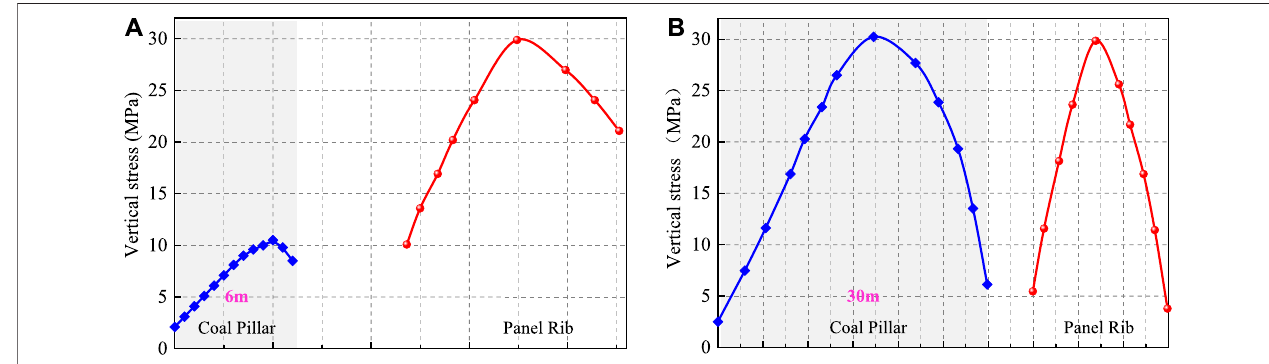
FIGURE 1 | Vertical stress redistribution characterization of narrow and wide coal pillar. (A) Narrow coal pillar; (B) Wide coal pillar.